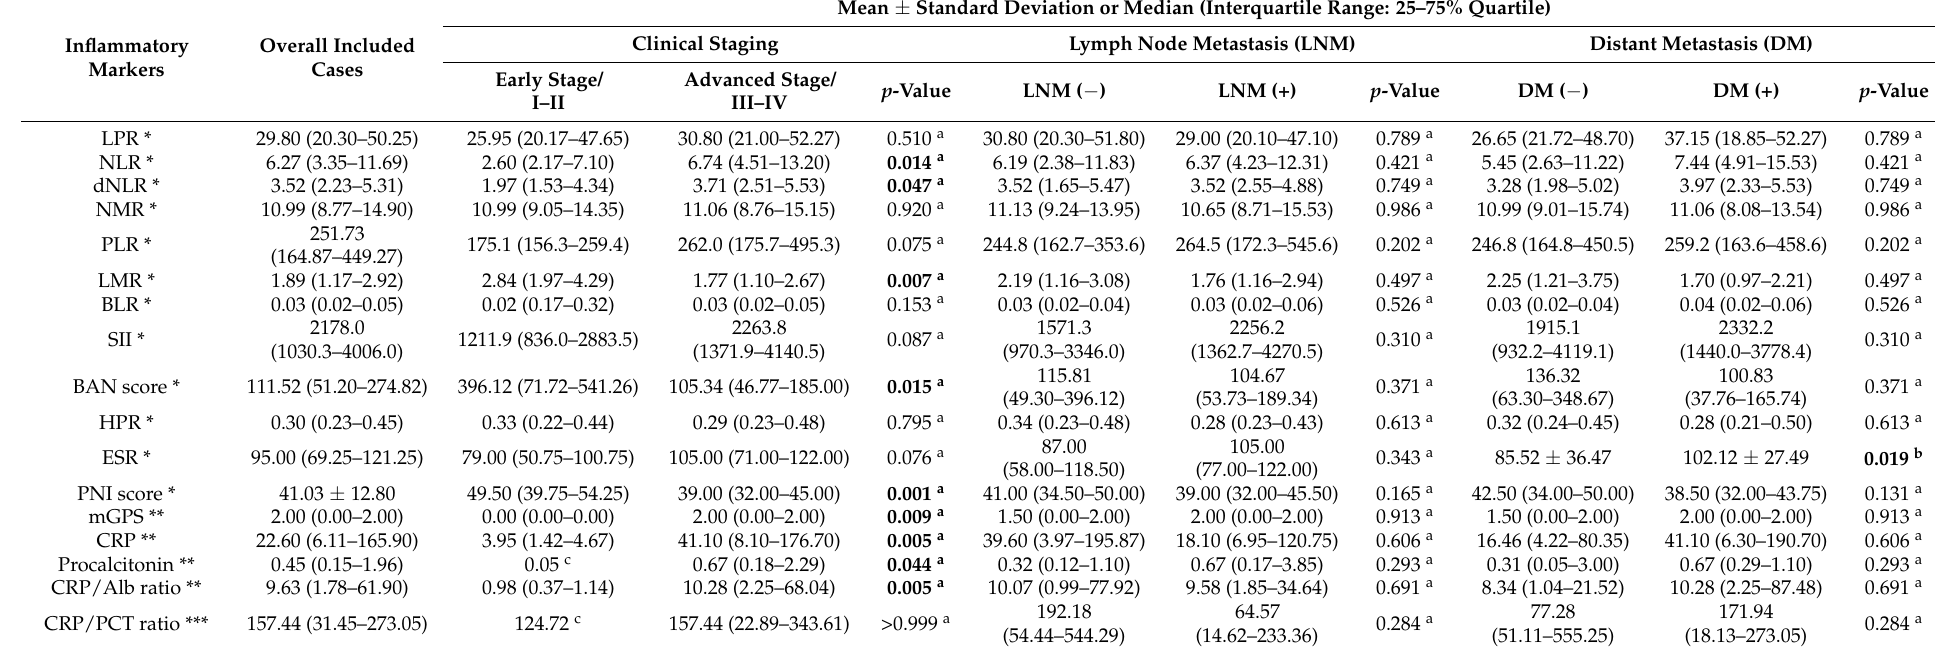
Table 2. Baseline characteristics of inflammatory marker calculation